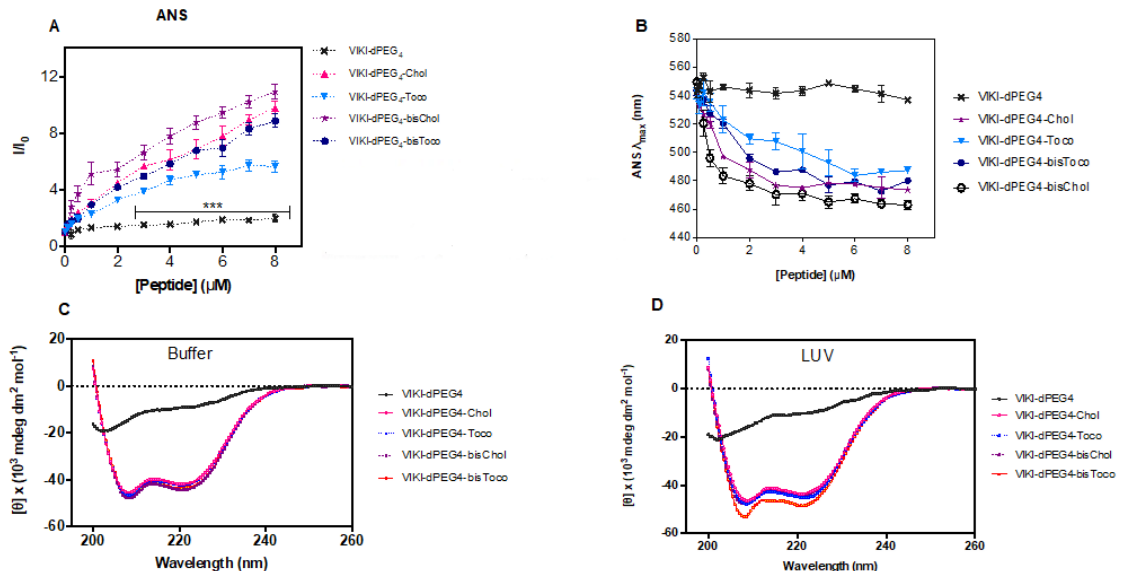
Figure 4. Concentration-dependent aggregation of the VIKI peptides. ( A ) Peptide aggregation in aqueous solution was evaluated by ANS (12.8 μM) fluorescence emission (λ exc = 369 nm; emission spectra integrated from 400 to 600 nm). The values are means ± SEM of at least three experiments. Statistical analysis was performed using a 2-way ANOVA test (*** p < 0.001). ( B ) The fluorescence emission maximum wavelength was plotted as a function of peptide concentration. Secondary structure of the VIKI-derived peptides determined by CD: spectra were obtained for VIKI-dPEG 4 (20 μM), VIKI-dPEG 4 -Chol (20 μM), VIKI-dPEG 4 -Toco (20 μM), VIKI-dPEG 4 -bis-Chol (20 μM), and VIKI-dPEG 4 -bis-Toco (13 μM), in phosphate buffer pH 7.4, at 25 °C, in the presence of ( C ) 2 μM DM detergent, and ( D ) 2 mM POPC LUV. All values are means from at least three independent experi- ments.